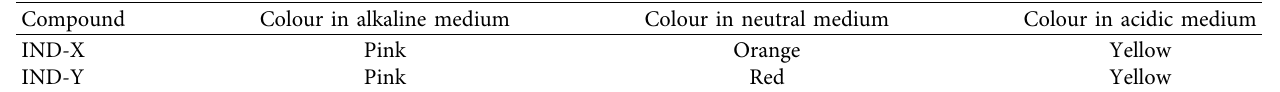
Figure 3: UV-Vis spectra of synthesised indicators (a: IND-X; b: IND-Y) in ethanolic/0.5 M NaOH solution. (a) UV-Vis spectrum of IND- X. (b) UV-Vis spectrum of IND-Y. Table 1: Indicator colour changes in different conditions.